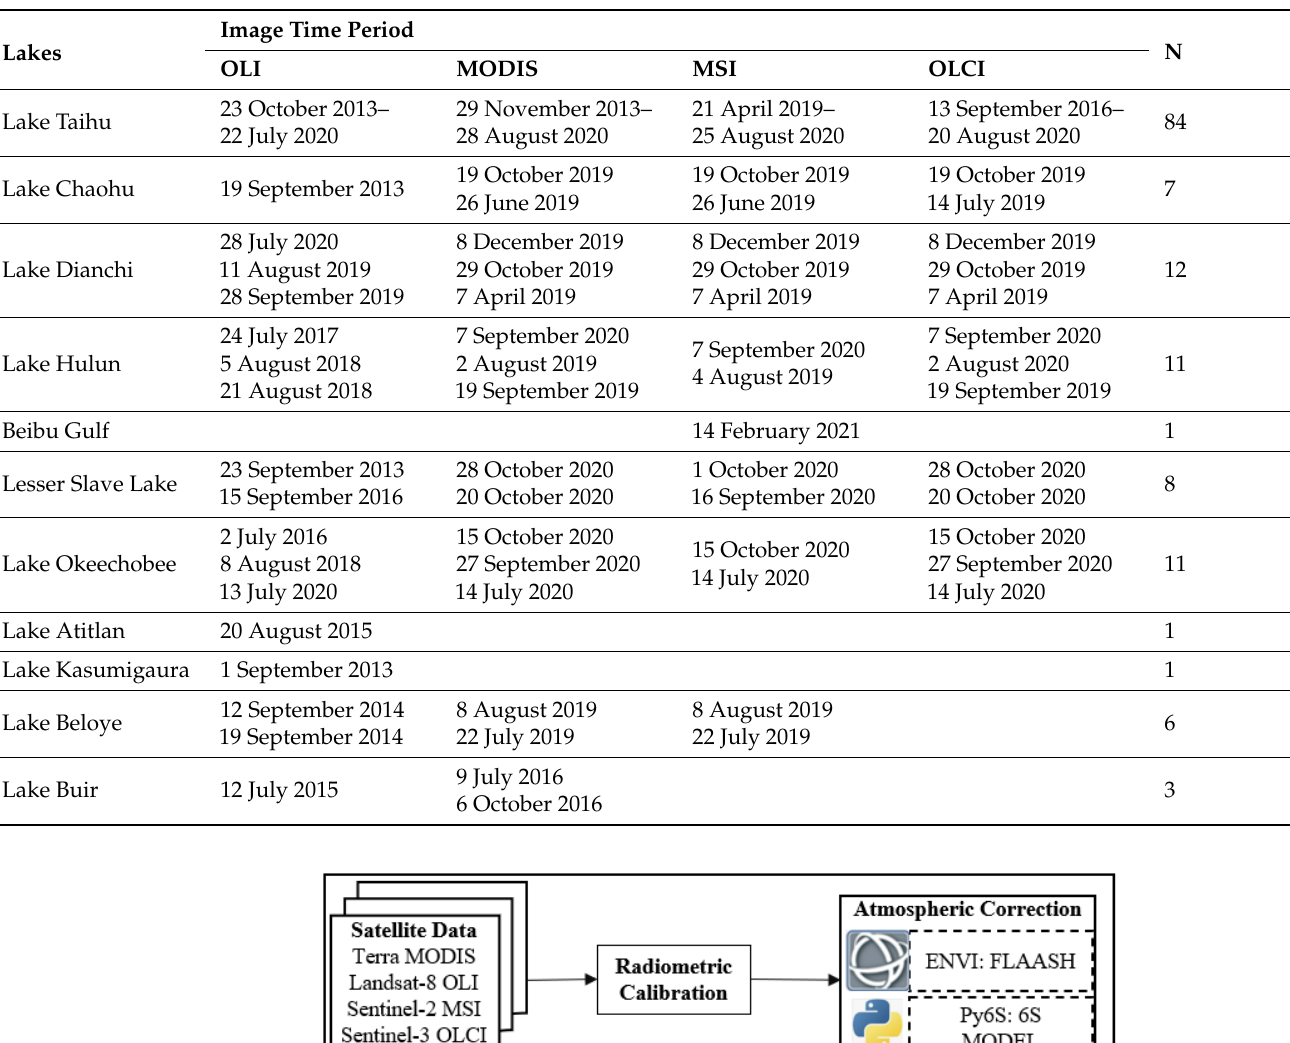
Table 2. Dates and numbers (N) of available satellite images of each lake. Image Time Lakes